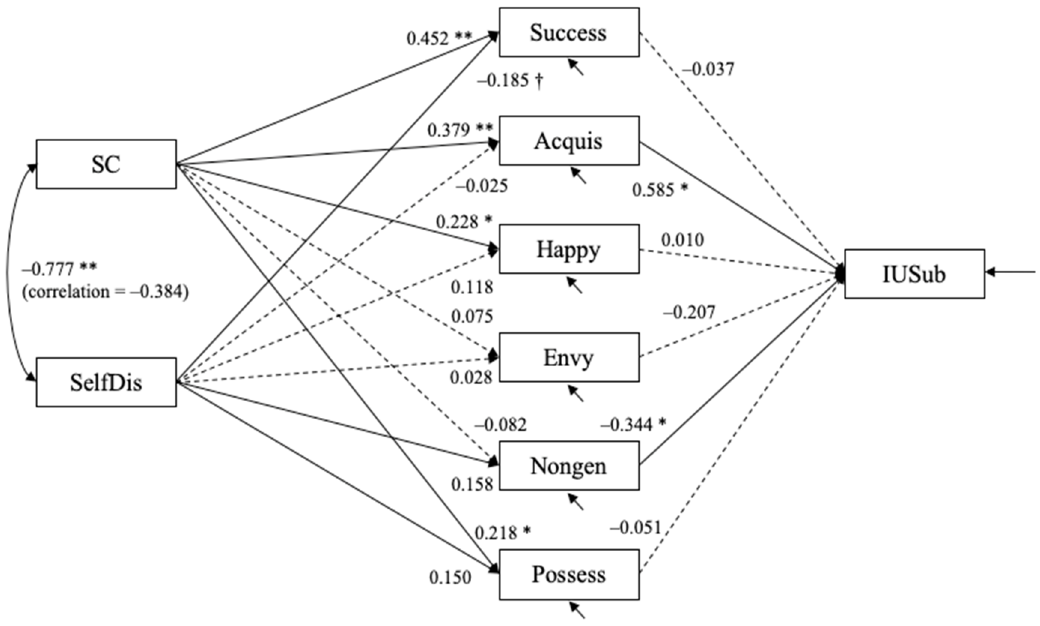
Figure 5. Study 1: Estimated structural equation model with subjective measure of Instagram usage (N = 108).